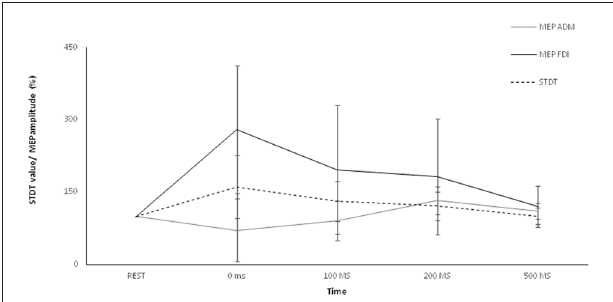
FIGURE 3 | Control experiment. Movement-induced STDT value changes during index finger abduction perfomed at maximum force and index finger flexion performed at 10% of maximum force. STDT values changes showed a similar time course during the two motor tasks but the modulation was higher when the subjects perfomed an index finger abduxtion with the maximum force level. X axis refers to the time course (baseline, 0 ms, 100 ms, 200 ms, 500 ms). Y axis refers to the percentage of STDT values change during movement. Vertical bars denote SD.